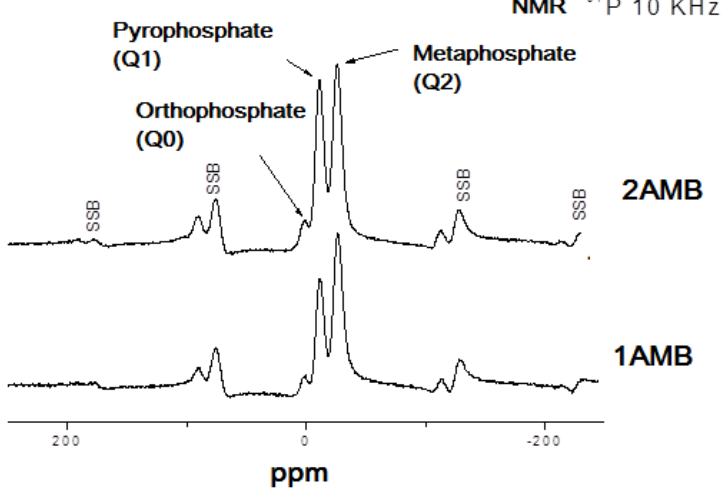
Figure 5. 31 P NMR spectra of the samples 2AMB and 1AMB. SSB—spinning side bands. The NMR resonance bands could be used to estimate the relative concentrations of the metaphosphate, pyrophosphate, and orthophosphate structural units in the ob-